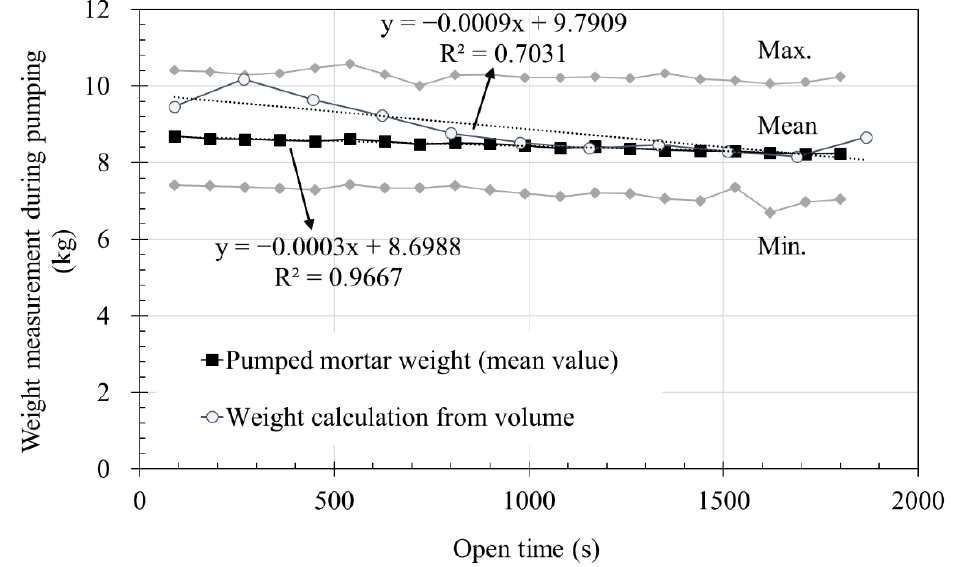
Figure 13. Volume of printed layer per cycle and cumulative printed layer volume.